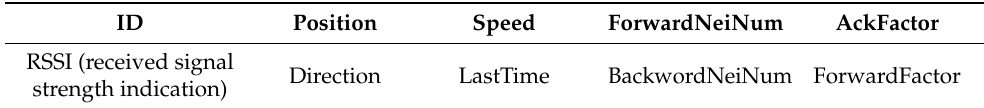
Table 3. The structure of the neighbor